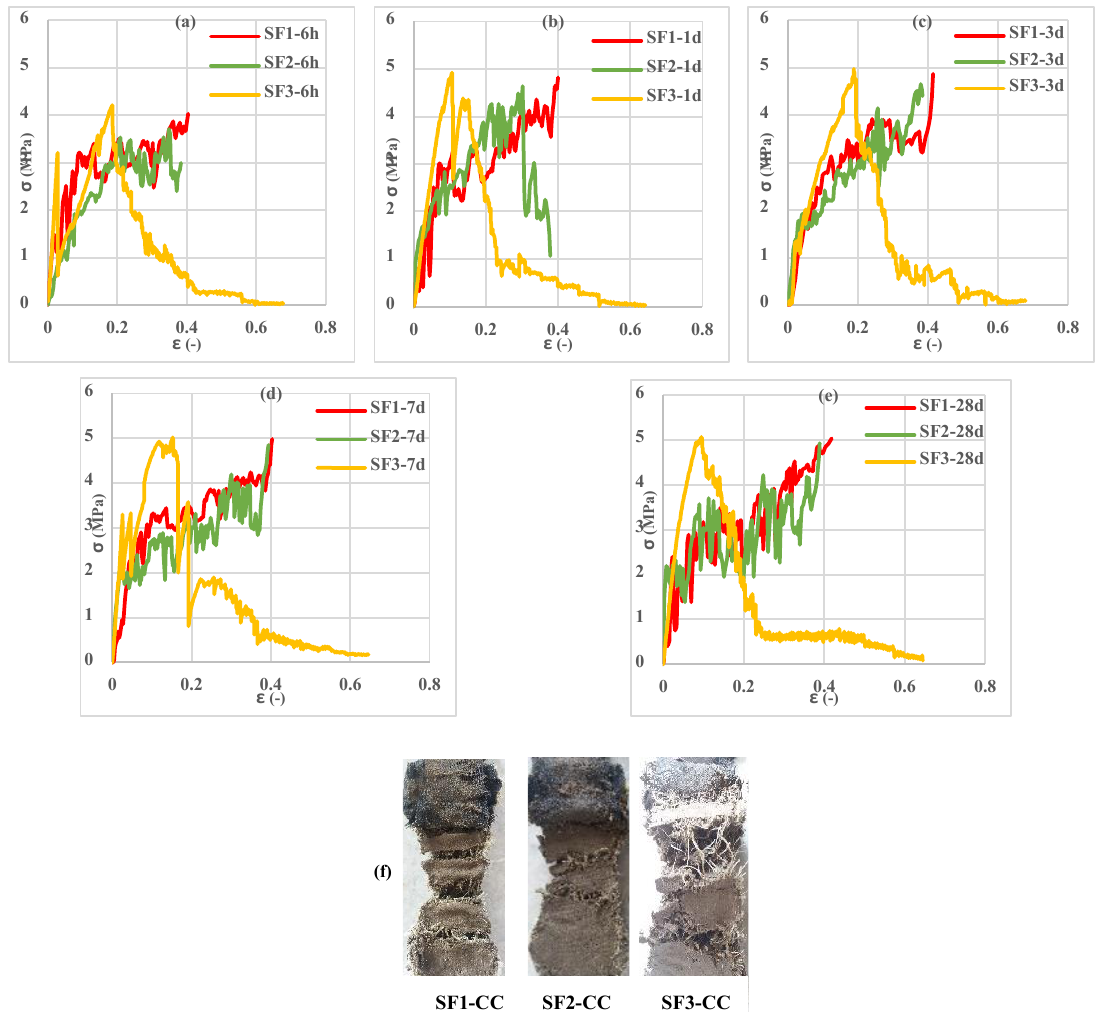
Figure 12. Tensile stress–strain curves of reinforced mortar with 3 types of spacer fabrics in the weft direction cured at 7 ◦ C temperature ( a ) 6 h, ( b ) 1 d, ( c ) 3 d, ( d ) 7 d, ( e ) 28 d, and ( f ) weft specimens after tensile